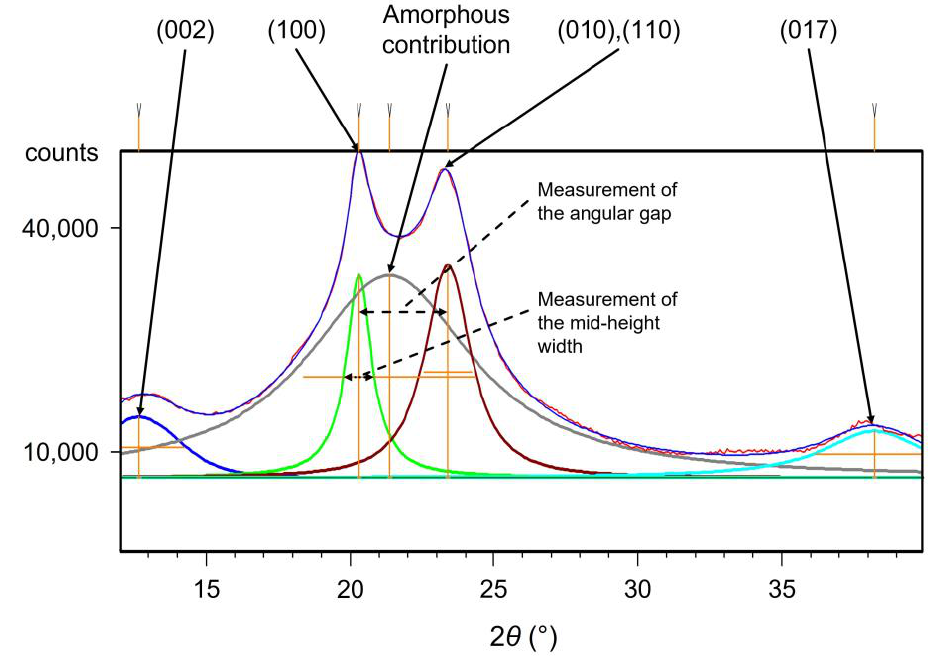
Figure 2. Typical decomposition of a PA66 diffractogram, with the identified plan families.